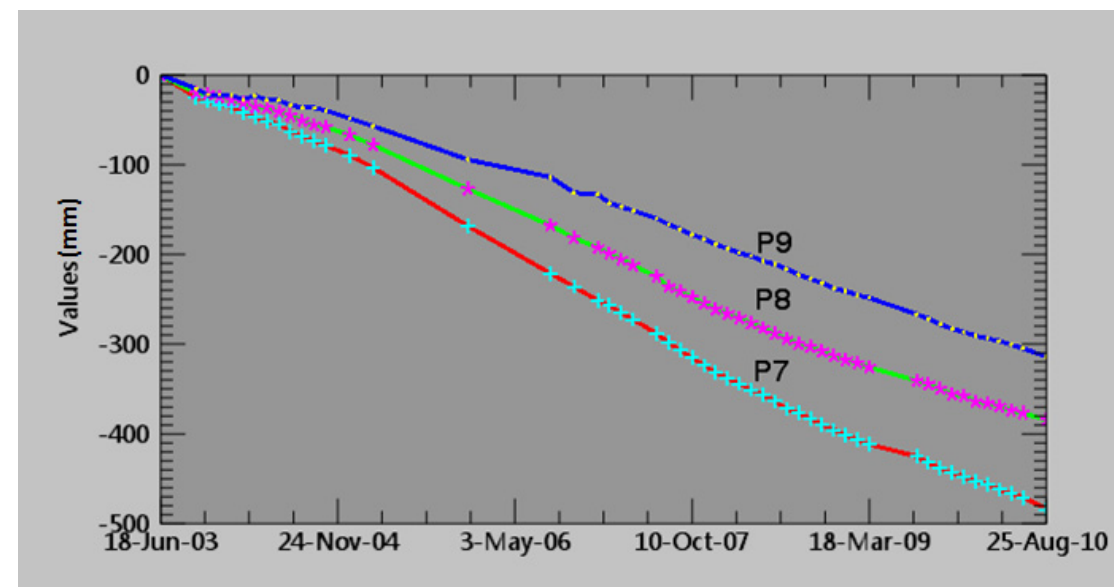
Figure 7. Displacement history for the three typical points (P7, P8 and P9, marked in Figure 4) within the subsidence funnel zone